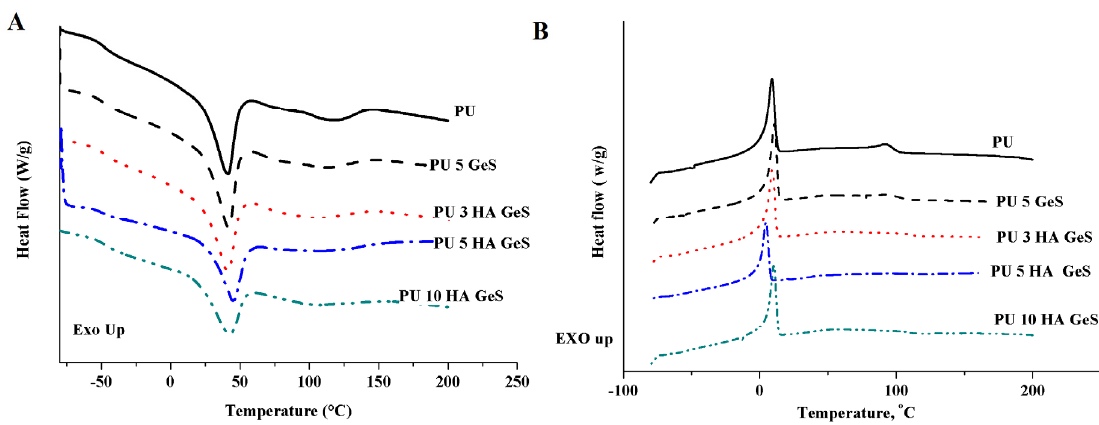
Figure 4. Thermal-analysis results: ( A ) DSC 2nd-heating scan; ( B ) DSC-cooling scan.